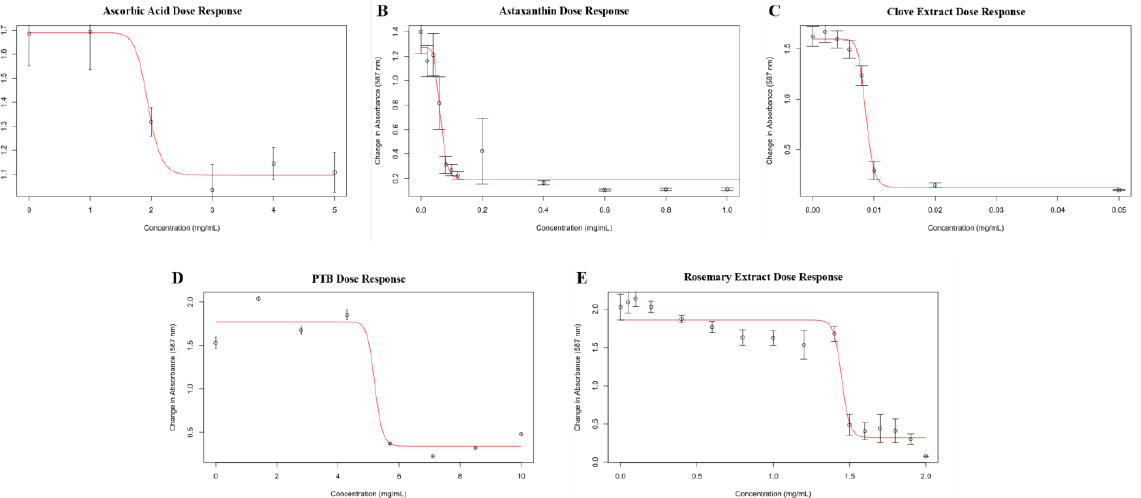
Figure A1. Biofilm Inhibition Logistic Regression. Effect of test compounds on S. aureus biofilm formation provoked by 0.5 mg/mL of glucose-keratin. ( A ) Ascorbic acid, R 2 = 0.99. ( B ) Astaxanthin, R 2 = 0.96. ( C ) Clove extract, R 2 = 0.99. ( D ) PTB, R 2 = 0.96. ( E ) Rosemary extract, R 2 = 0.94. Biofilm assayed after 48 h of growth under static conditions. n = 8. Mean ± standard deviation. Logistic regression analysis performed using the dose–response curve package in R.